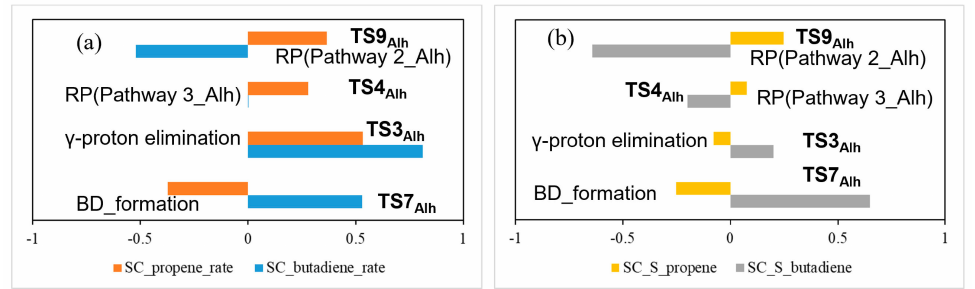
Figure 6. Microkinetic analysis corresponding to the hydroxylated Al 2 O 3 model: ( a ) sensitivity analysis for rates of product formation; ( b ) sensitivity analysis for selectivity of product formation. (TS: Transition State; SC = Sensitivity Coefficient; RP = Retro-Prins; BD =